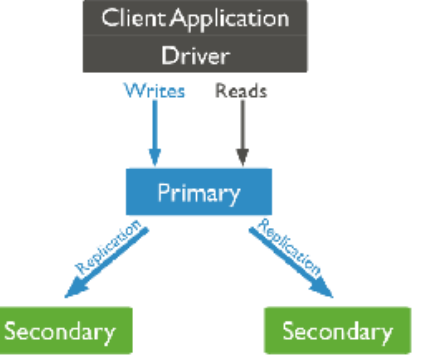
Figure 2. DBMS Architecture of the proposed simulated